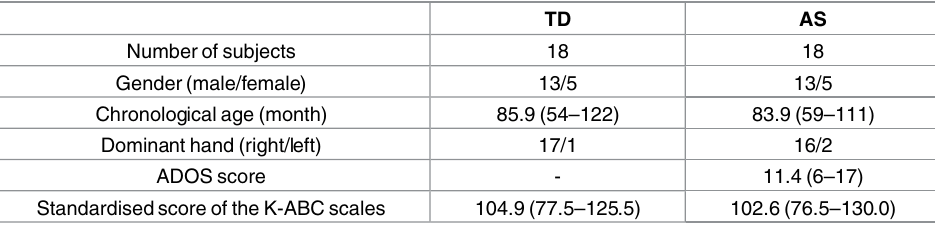
Table 1. Demographicsof the